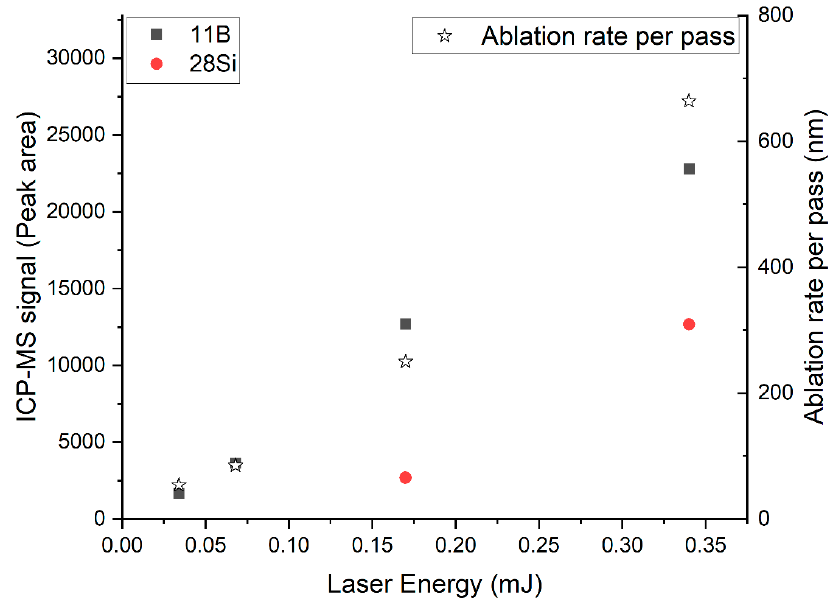
Figure 3. Dependence of the ablation rate and the ICP-MS signal from the applied laser energy.